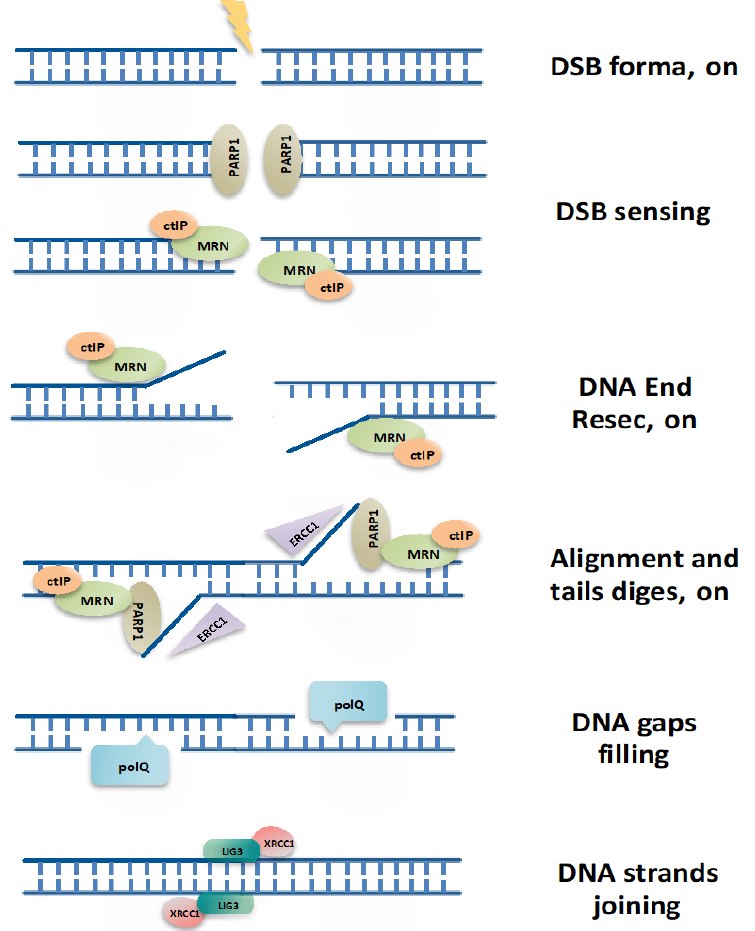
Figure 1. Alt-NHEJ machinery. Different steps and core components involved in DSB repair by Alt-NHEJ pathway. Alt-NHEJ, alternative non-homologous end joining; DSB, double-strand break.